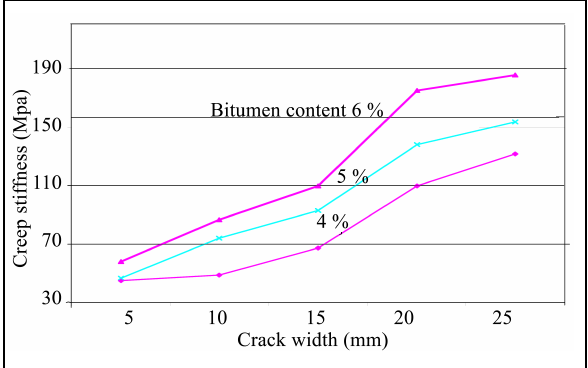
Fig 7. Effect of bitumen content and crack widths on creep stiff- ness